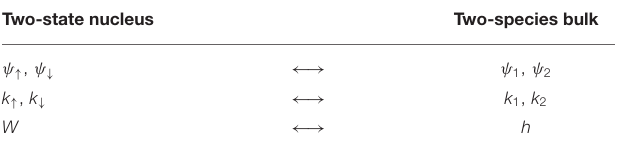
TABLE 2 | The dictionary that maps quantities in a unitary two-species theory to quantities in a non-unitary single-species